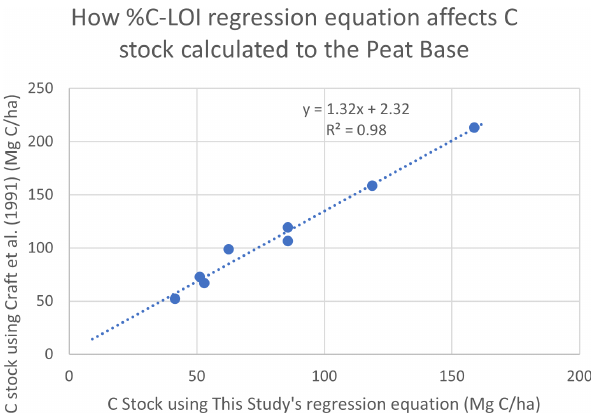
Figure A4. Comparison of C stocks (MgCha − 1 ) estimated using the Craft et al. (1991) equation versus C stocks estimated using this study’s empirical relationship for southern BC, for eight cores from our study region. Comparison suggests that using the Craft et al. (1991) relationship would produce C stocks that are ∼ 32% greater than our estimates. This difference, while substantial, would not account for global C stocks that are 3 times larger than those found in Clayoquot Sound salt marshes.